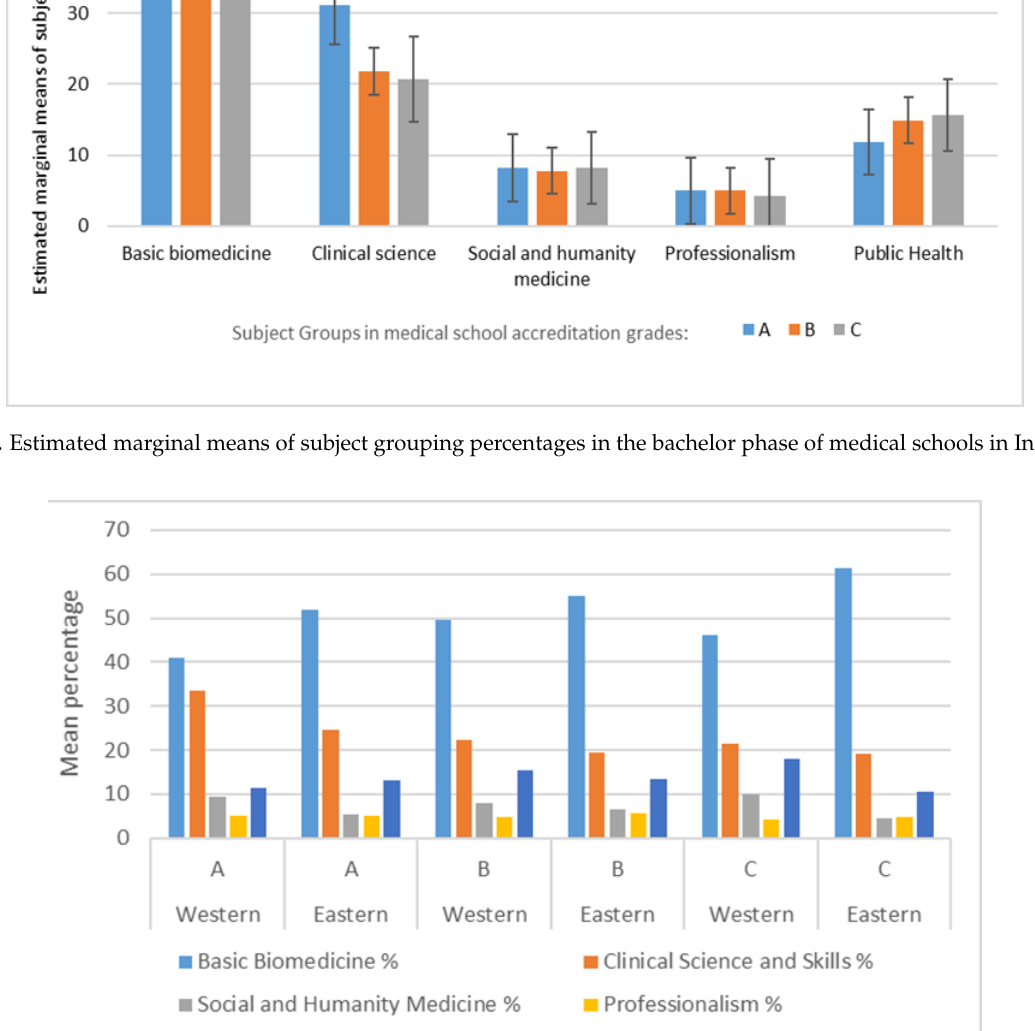
Figure 4. Comparison of curriculum topics according to accreditation grade (A, B, or C) and geographical location (Eastern or Western region).